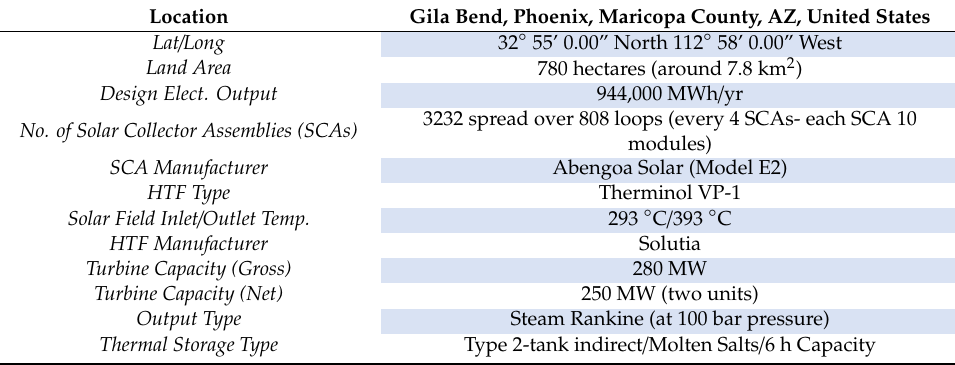
Table 3. Solana Project specifications